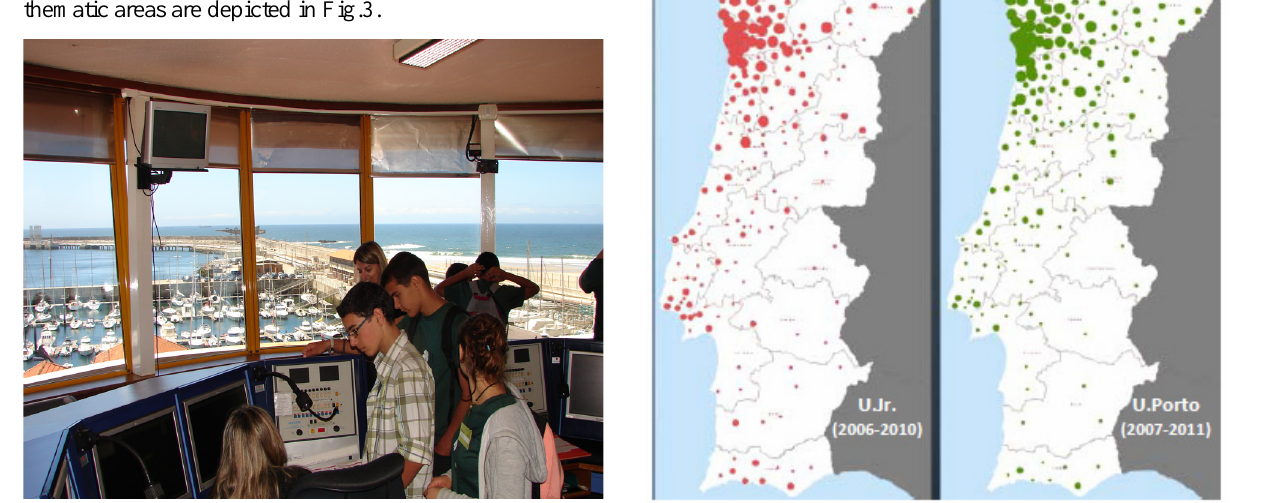
Figure 1. Field trip to Leixões Harbour control tower